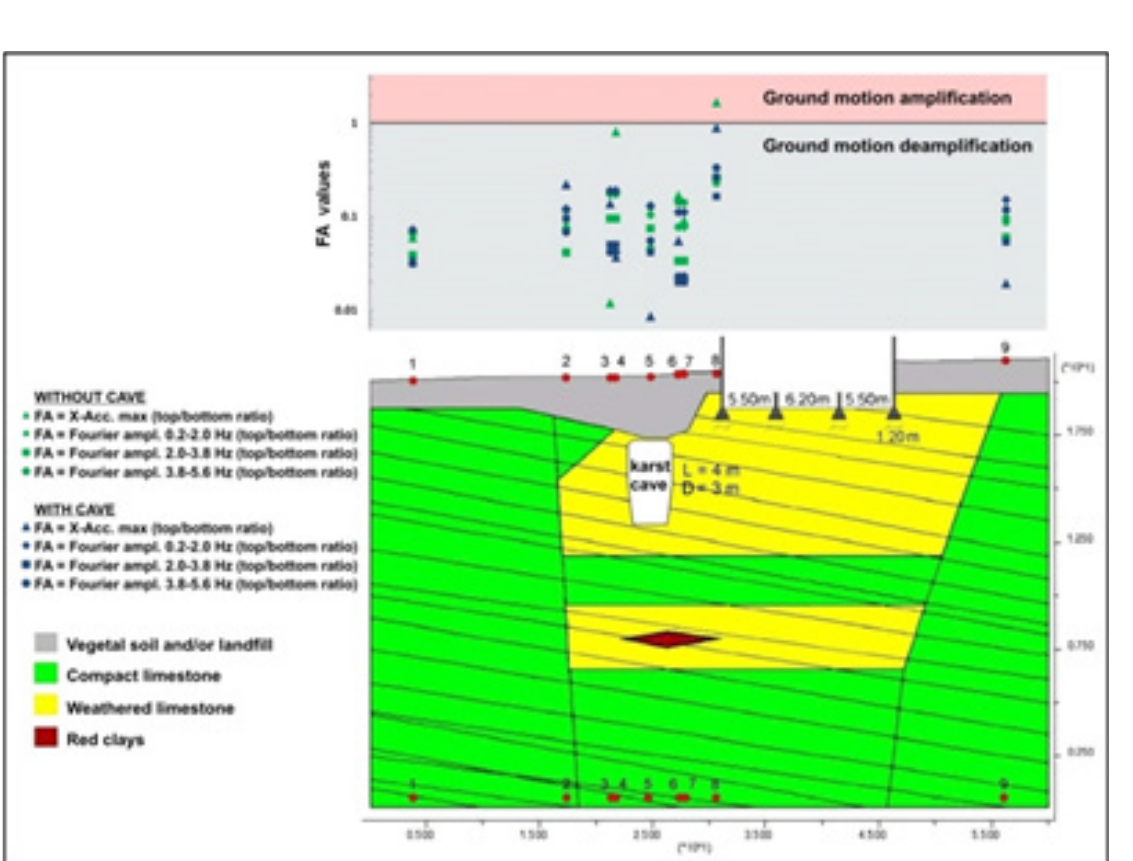
Figure 10: LSR amplification/deamplification, as X-accelerations FA, in each of the control points at the ground level of case study